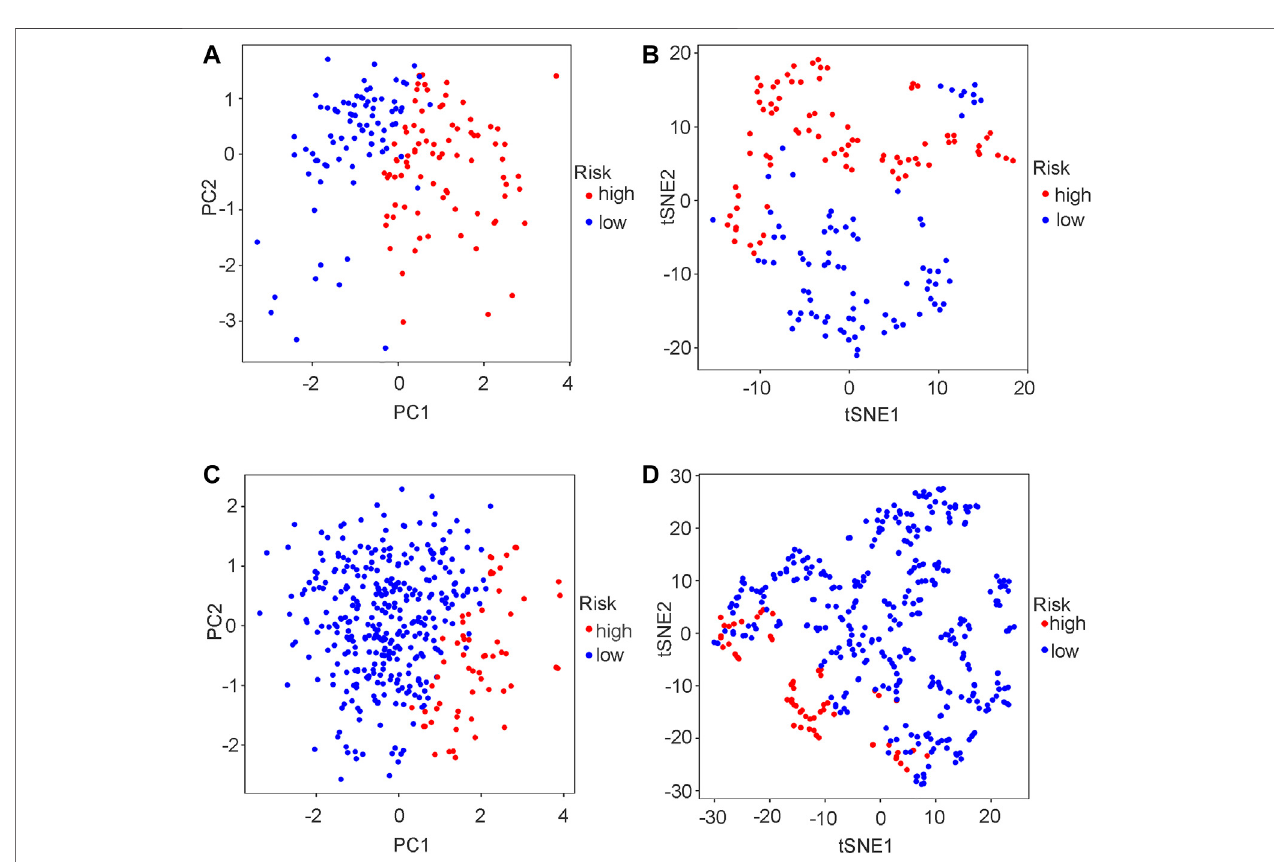
FIGURE 4 | PCA plot and t-SNE analysis in both GEO and TCGA cohort. (A) PCA plot in GEO cohort. (B) t-SNE analysis in GEO cohort. (C) PCA plot in TCGA cohort. (D) t-SNE analysis in TCGA cohort.